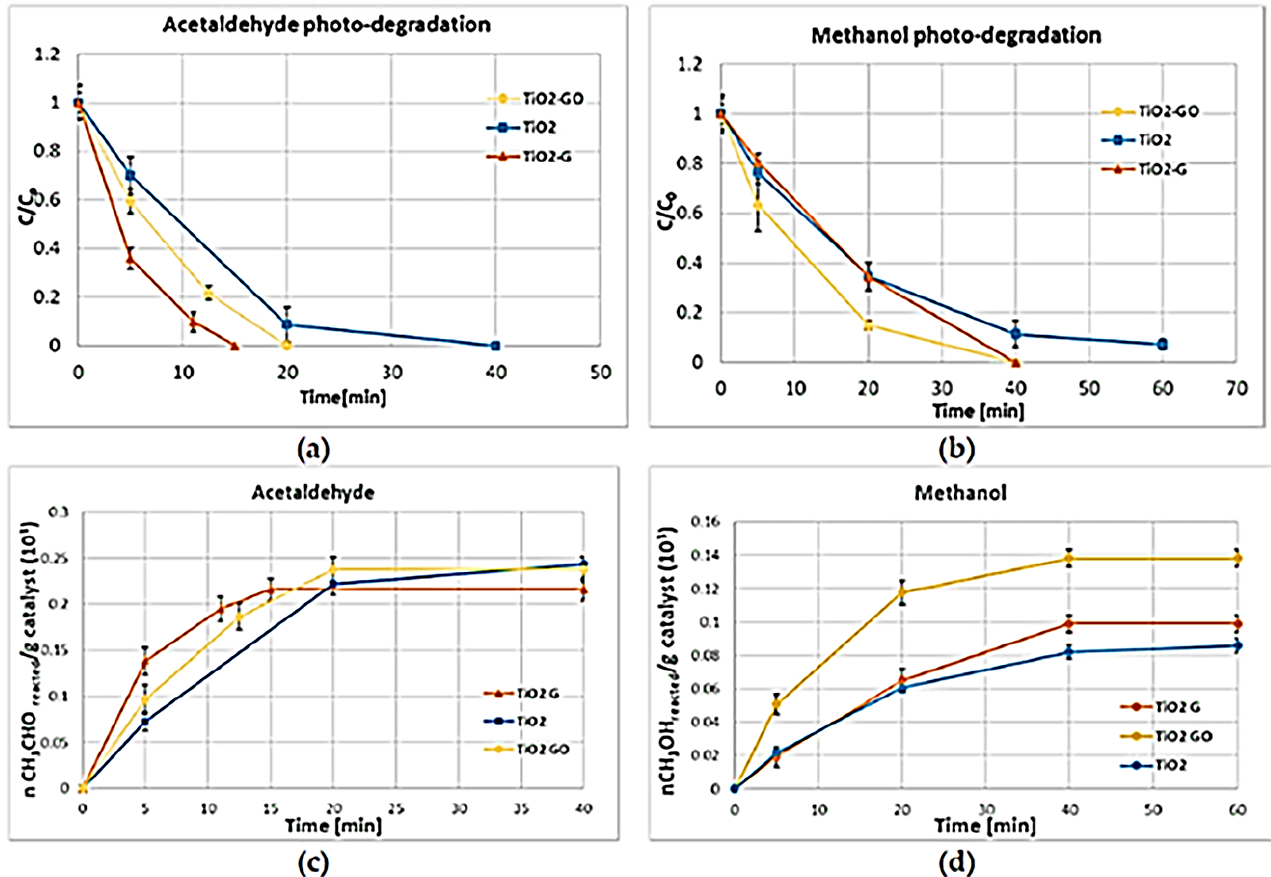
Figure 13. Acetaldehyde removal versus time ( a ) and normalized data on catalyst mass ( c ); Methanol removal versus time ( b ) and normalized data on catalyst mass ( d ) [224]. Reproduced with permission from MDPI.